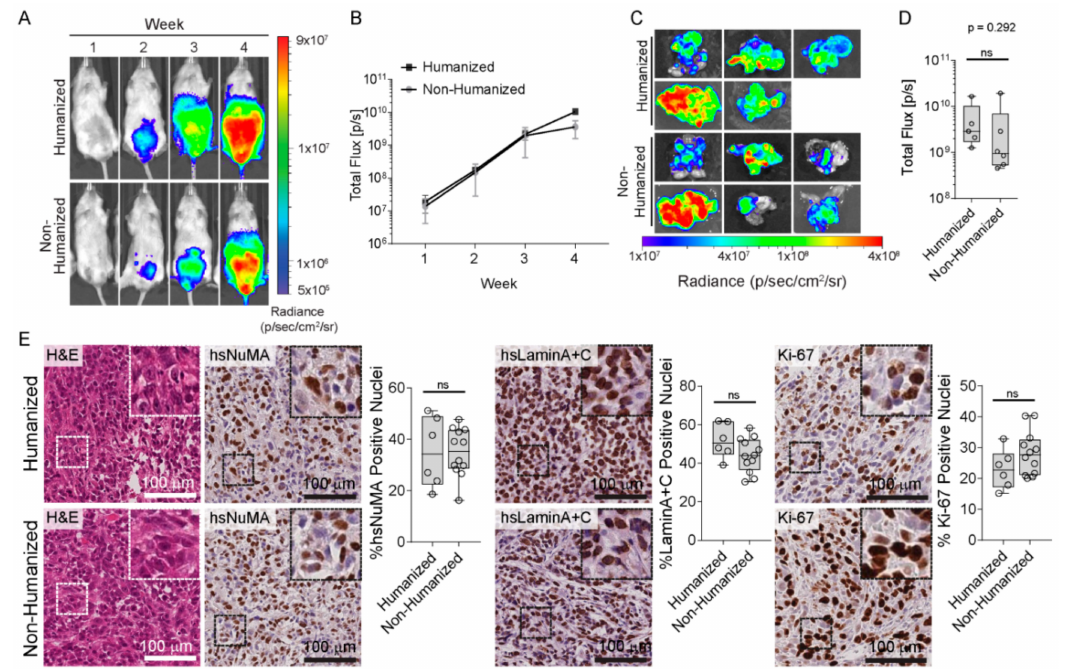
Figure 2. PC3-luc cells form an orthotopic primary prostate tumor in vivo. ( A ) Representative in vivo bioluminescent images (BLI) over 4 weeks following intraprostatic injection. ( B ) Quantification of the in vivo BLI signal in mice with the humanized (black squares) compared to the non-humanized (grey circles) prostate microenvironment (n = 5–6 mice per group; mean ± SEM). ( C ) Ex vivo BLI images of the murine prostate tissues at the 4 weeks experimental endpoint and ( D ) corresponding BLI signals (n = 5–6 prostate tissues; individual data points are shown) demonstrates that there were no significant differences in orthotopic prostate tumor burden between the humanized and non-humanized prostate groups ( p = 0.292). Data are represented as individual values within the box plot. Statistical analysis was performed using an independent t -test. ( E ) Representative histological and immunohistochemical images of the prostate tumors, stained with H&E, hsNuMA, hsLaminA+C and Ki-67. ns: not significant. Scale bars represent 100 µ